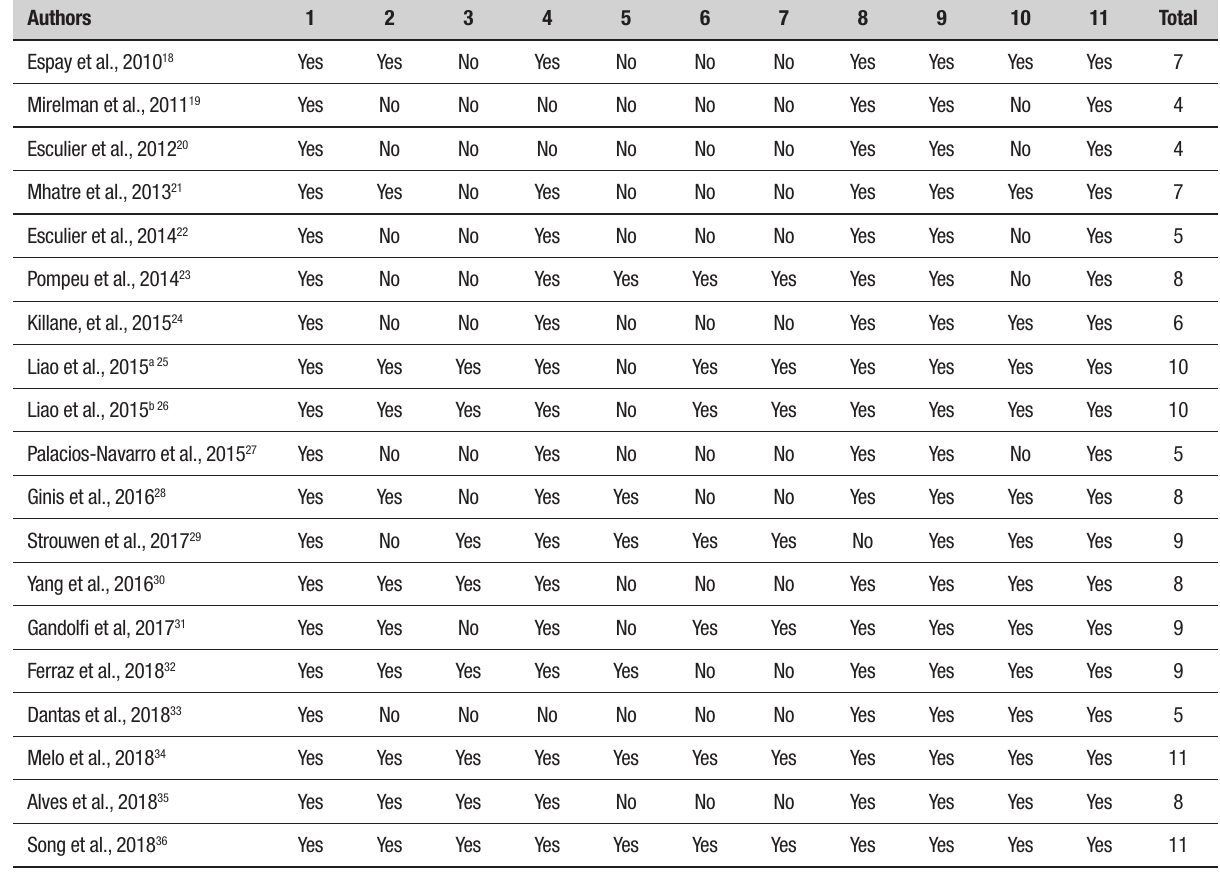
Table 2. PEDro database